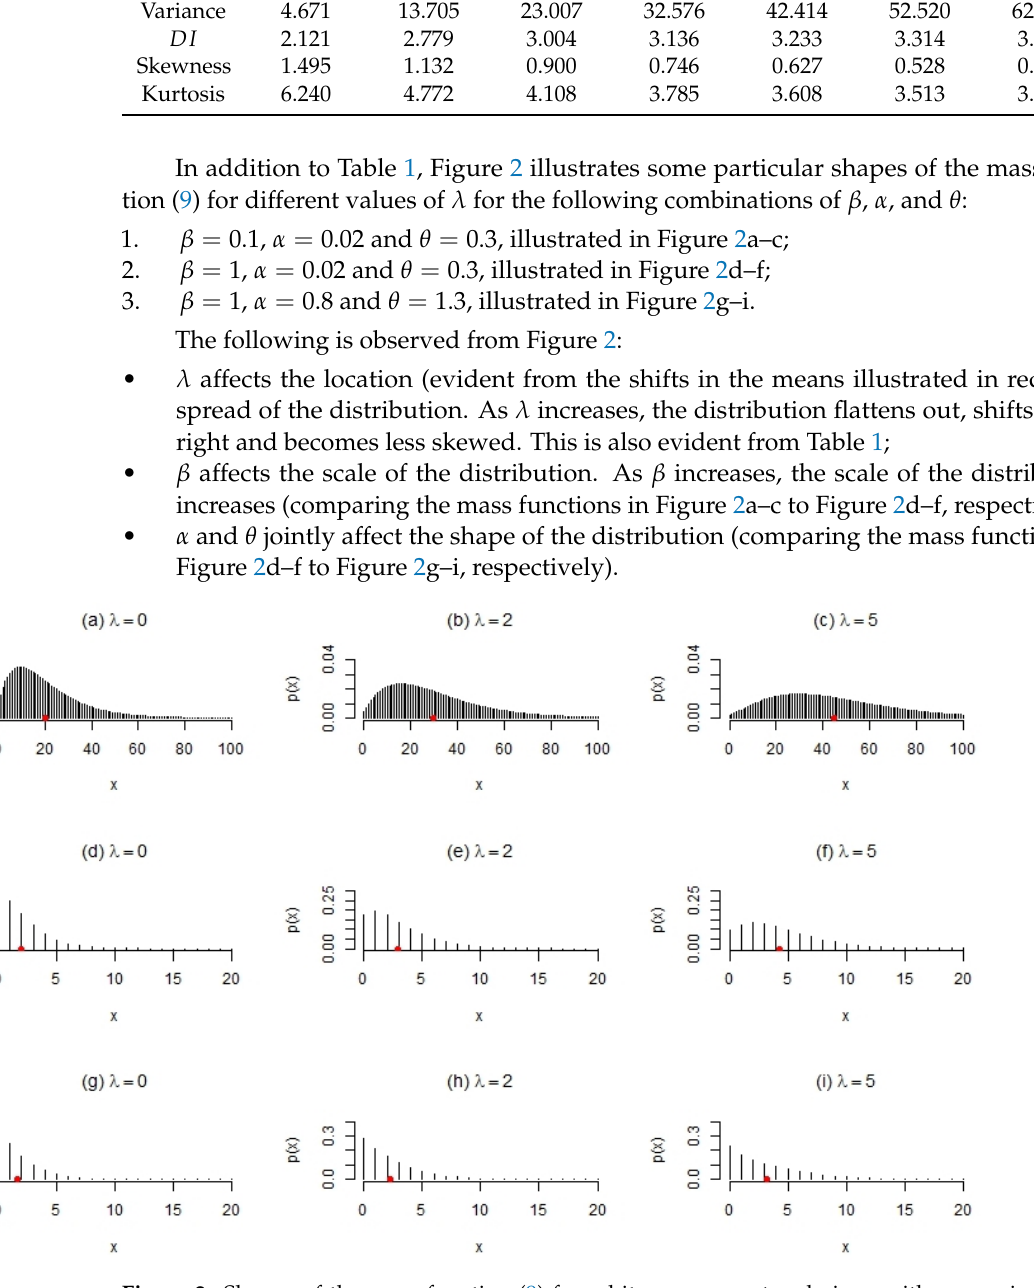
Figure 2. Shapes of the mass function (9) for arbitrary parameter choices, with means indicated in red. ( a – i ) some particular shapes of the mass function (9) for different values of λ for the following combinations of β , α , and θ